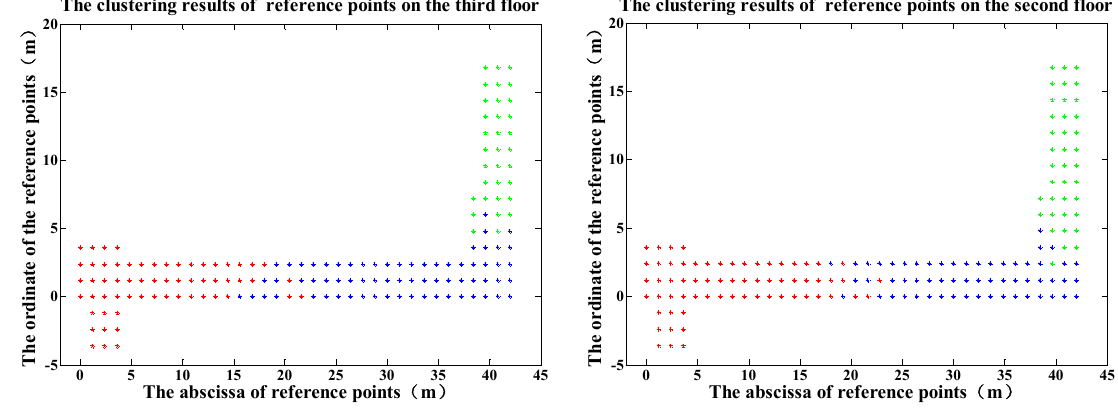
Figure 9. The clustered results of reference points on two floors.